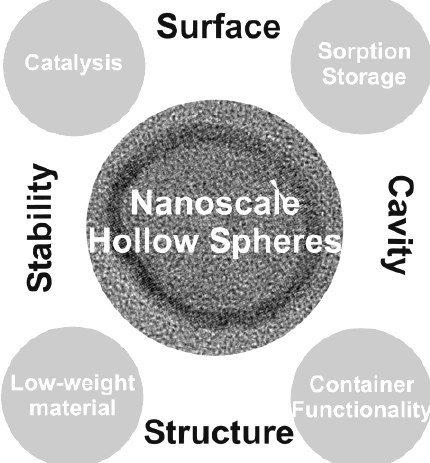
Figure 24. Future perspectives of nanoscale hollow spheres: properties and potential areas of